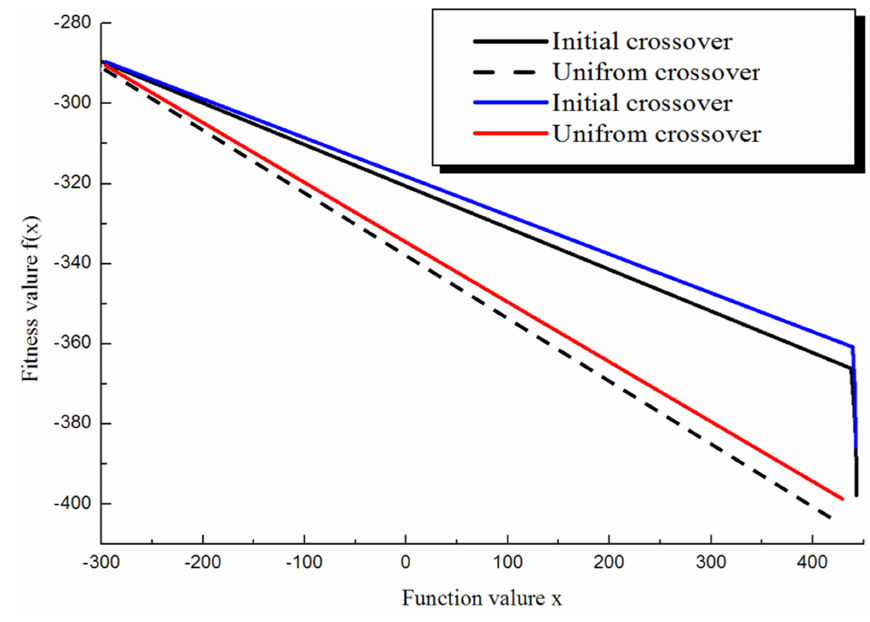
Figure 8. Comparison of fitness values for crossover